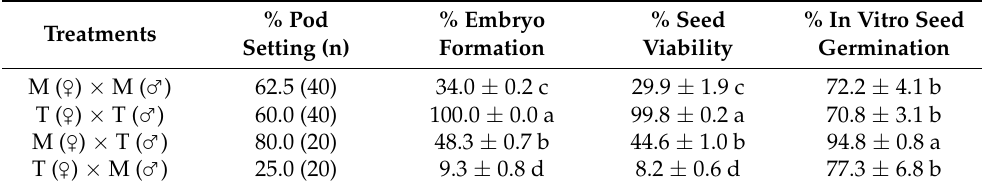
Table 1. Pod setting, seed set, seed viability and seed germination of intra- and interspecific hy- bridization between Phaius mishmensis (M) and P. tankervilliae (T). % Pod % Embryo % Seed % In Vitro Seed Treatments Setting (n) Formation Viability Germination M ( ♀ ) × M ( ♀ ♂ Values are means ± SE. Different letters within the same column indicate significant differences analyzed by Duncan’s new Multiple Range Test (DMRT) at p < 0.05 and the number in parentheses mean the number of pollinated flowers.